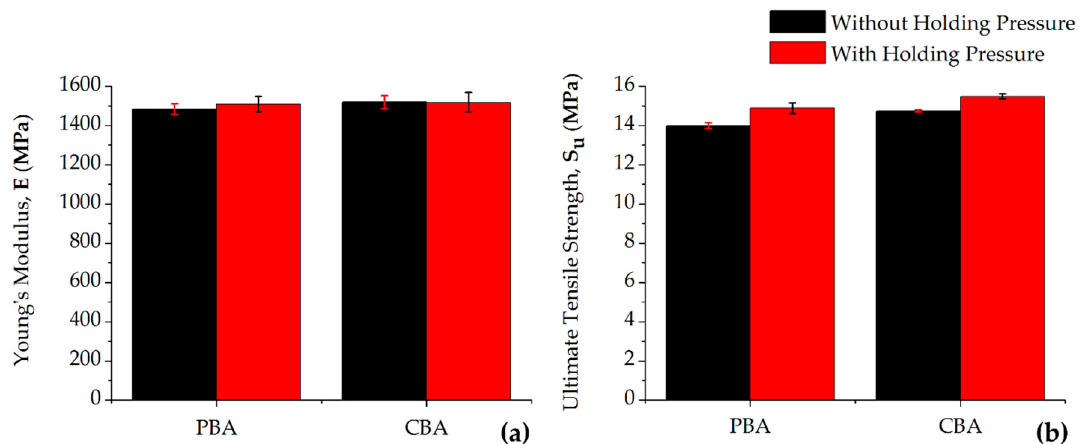
Figure 7. ( a ) Young’s modulus (E) and ( b ) ultimate tensile strength (S u ) data of a physical blowing agent (PBA) compared to a similarly processed chemical blowing agent (CBA).